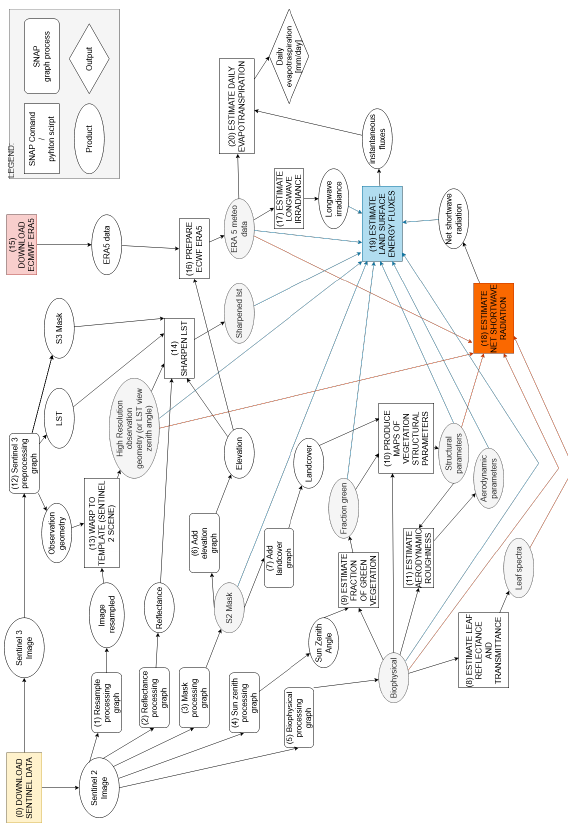
Figure 1. Sen-ET procedure